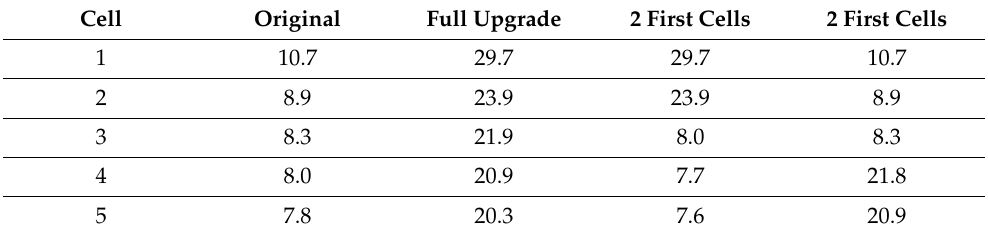
Table 2. Froth water recovery along the bank for the four scenarios.